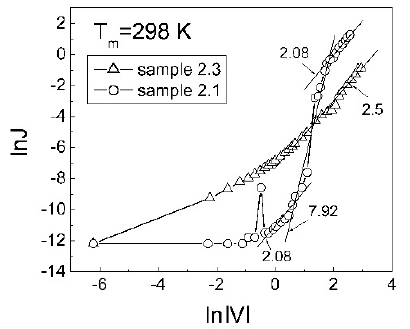
2–18 V. Since this slope is also higher than 2, this means that the charge transport in the p-type ZnO:N is also carried out via deep levels in the ZnO energy gap.